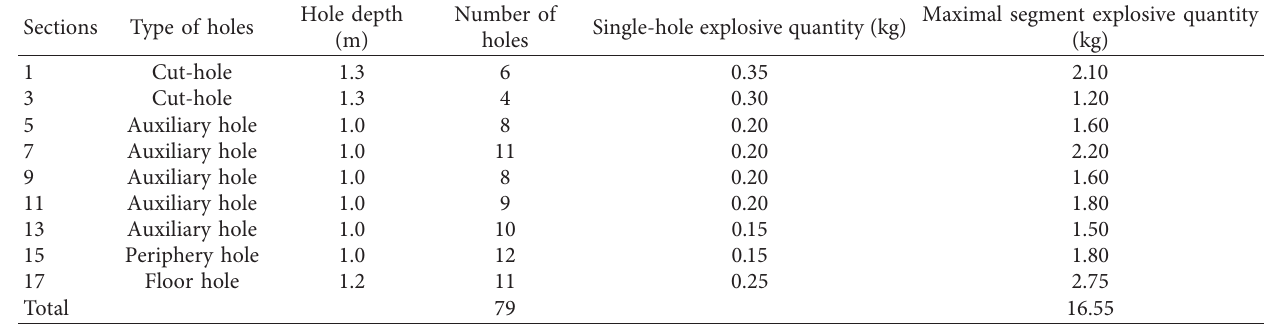
Table 1: Optimized blasting design parameters.